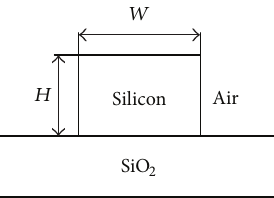
Figure 1: Geometry properties of the silicon waveguide. The lower cladding material is SiO 2 and the upper cladding material is air. 𝑊 = 0.7 𝜇 m denotes the width of the waveguide, and 𝐻 = 0.5 𝜇 m is the height of the waveguide.